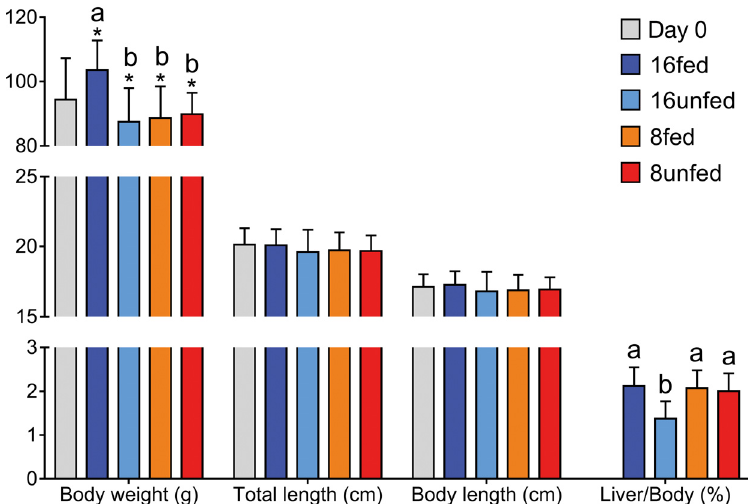
Fig. 1. Growth performance in different groups of yellow drum subjected to cold and starvation stresses. Data are shown as mean ± SE (n = 12). ( " ) Signifi- cant differences between conditions before and after the experiments; differ- ent letters indicate significant differences between the treatment groups